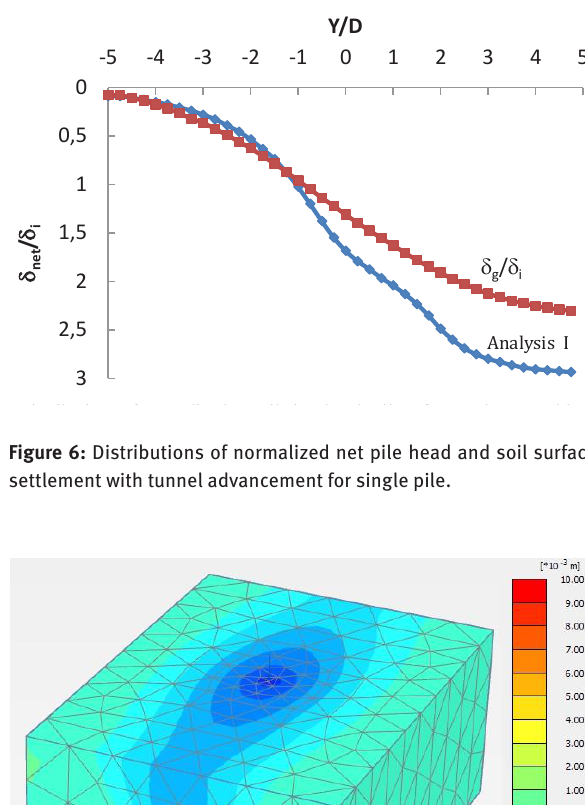
Fig. 7 Displacement of soil at the end of excavation Y/D= +5. (Analysis I)